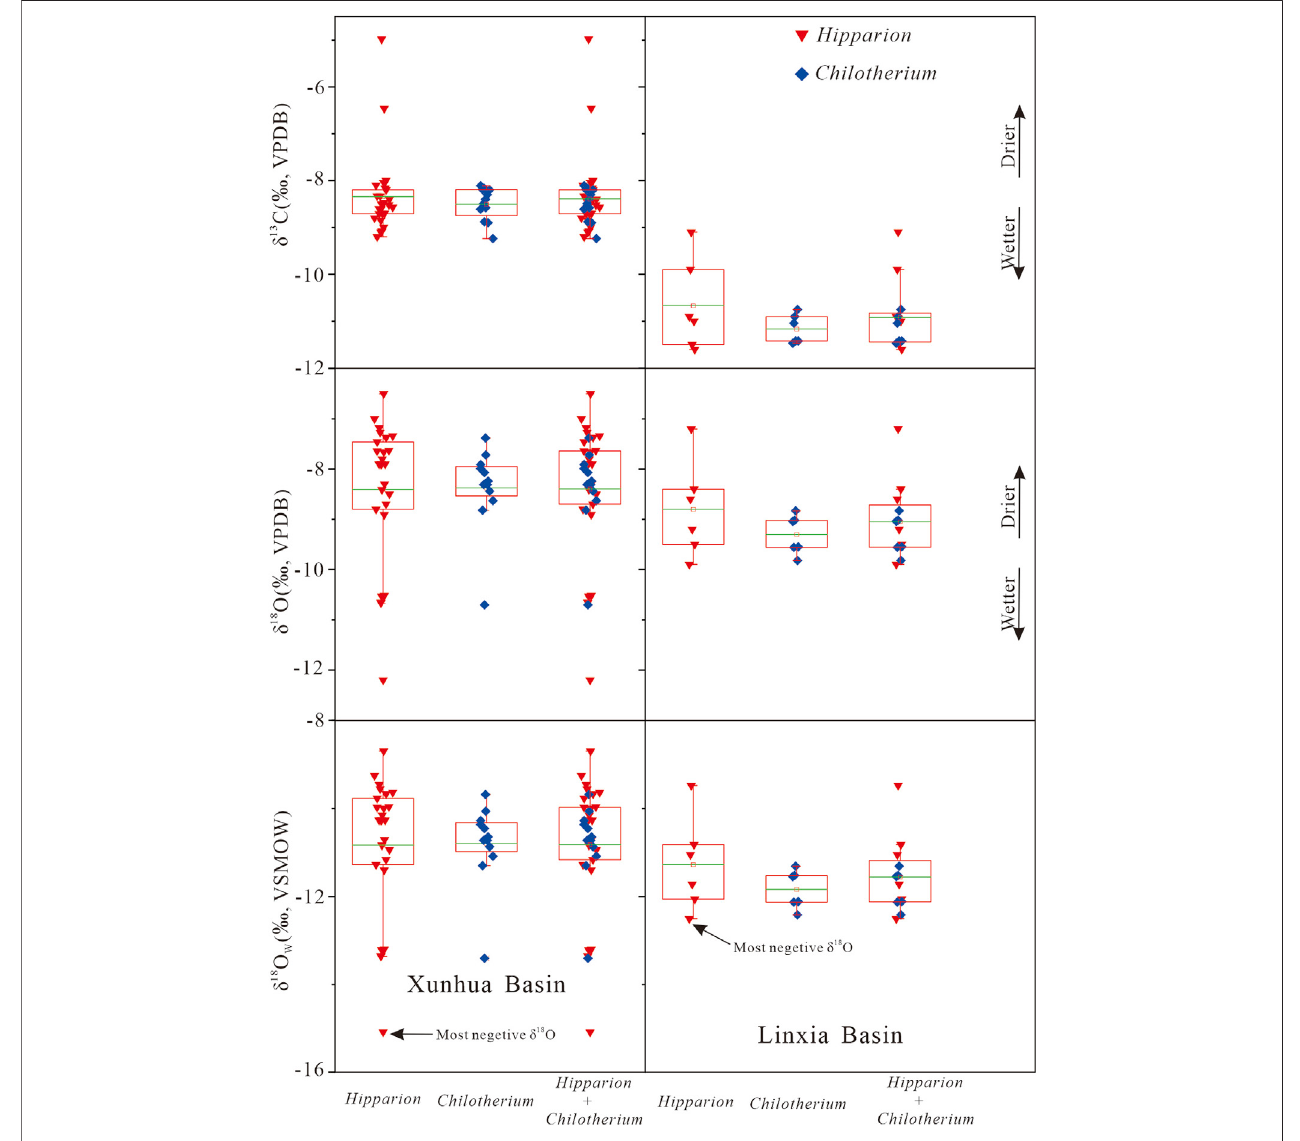
FIGURE7| Comparison ofenamel δ 13 C, δ 18 Oandtheestimated δ 18 O w valuesofobligatedrinkers( Hipparion and Chilotherium )ofXunhua Basinat ∼ 9 Maand the Linxia Basin at 9.5 to 9 Ma (Wang and Deng, 2005; Biasatti et al., 2010, 2018).